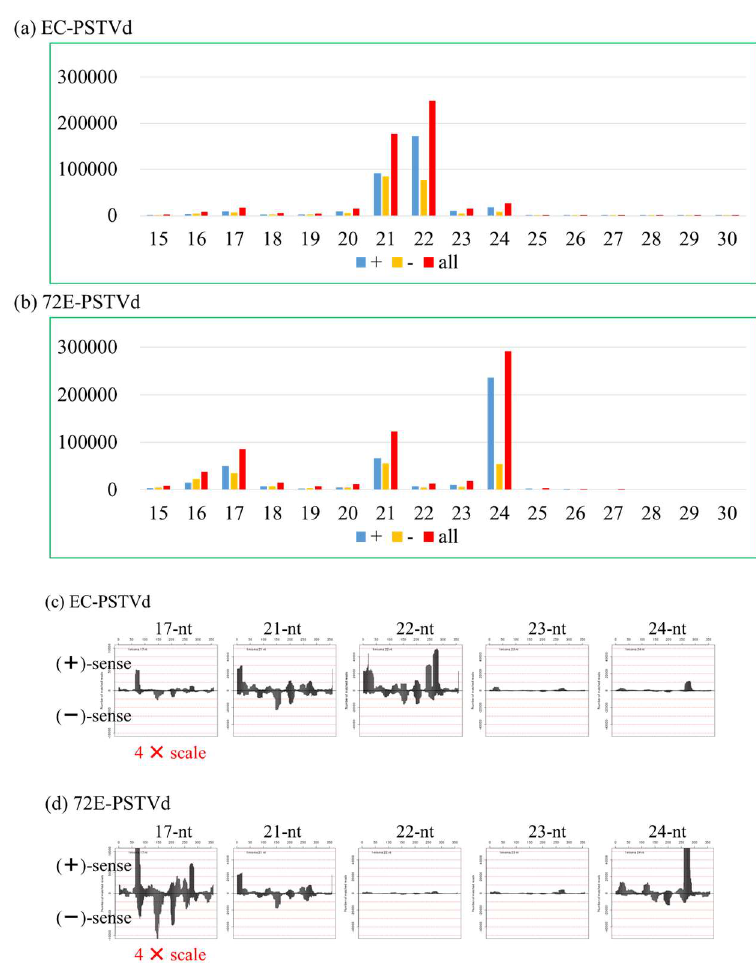
Figure 6. Size distribution and positive ( + ) / negative (–) ratio of PSTVd-sRNAs of the size 15–30 nt accumulated in lines ( a ) EC and ( b ) 72E. Panels ( c ) and ( d ) compare the PSTVd-sRNA hotspot patterns for the 17 nt, 21 nt, 22 nt, 23 nt, and 24 nt species in lines EC (c) and 72E (d).